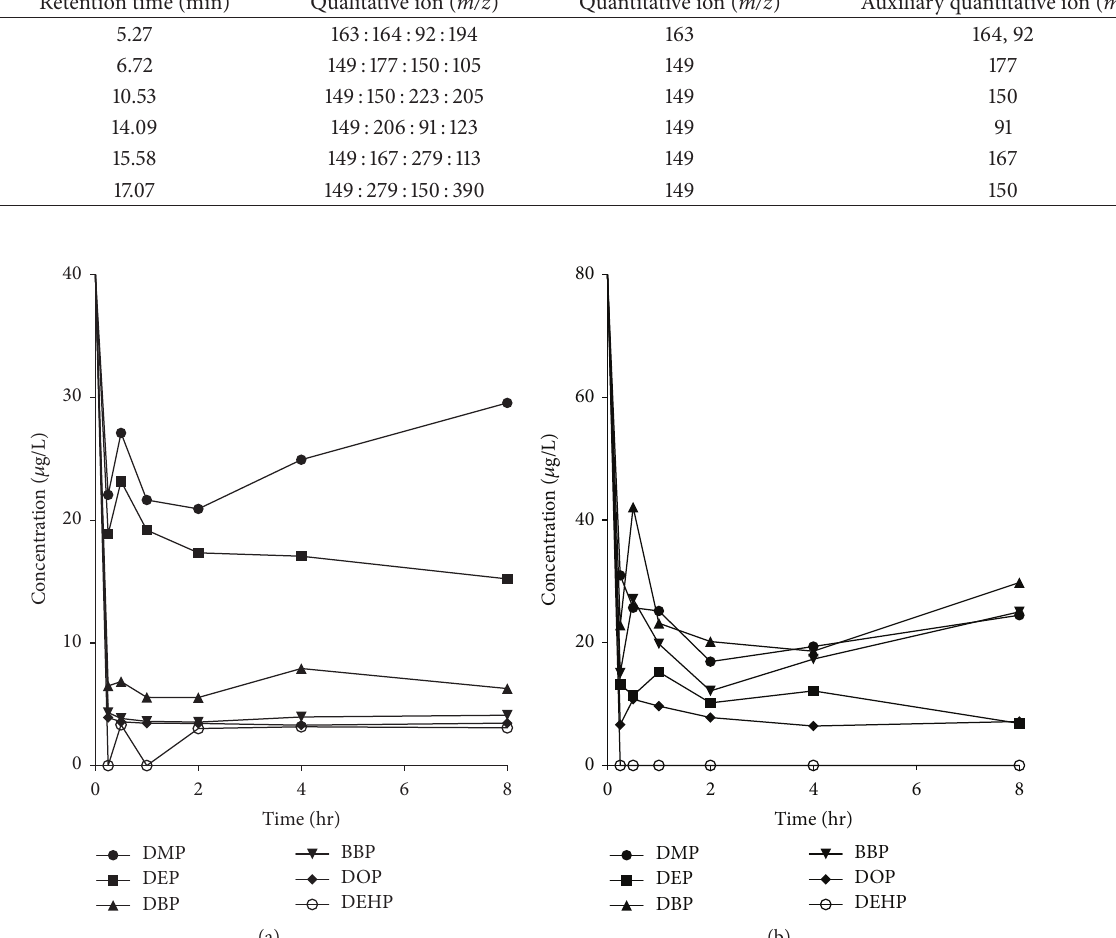
Figure 1: The change of PAEs in water phase over time with initial concentration of 40 𝜇 g/L (a) or 80 𝜇 g/L